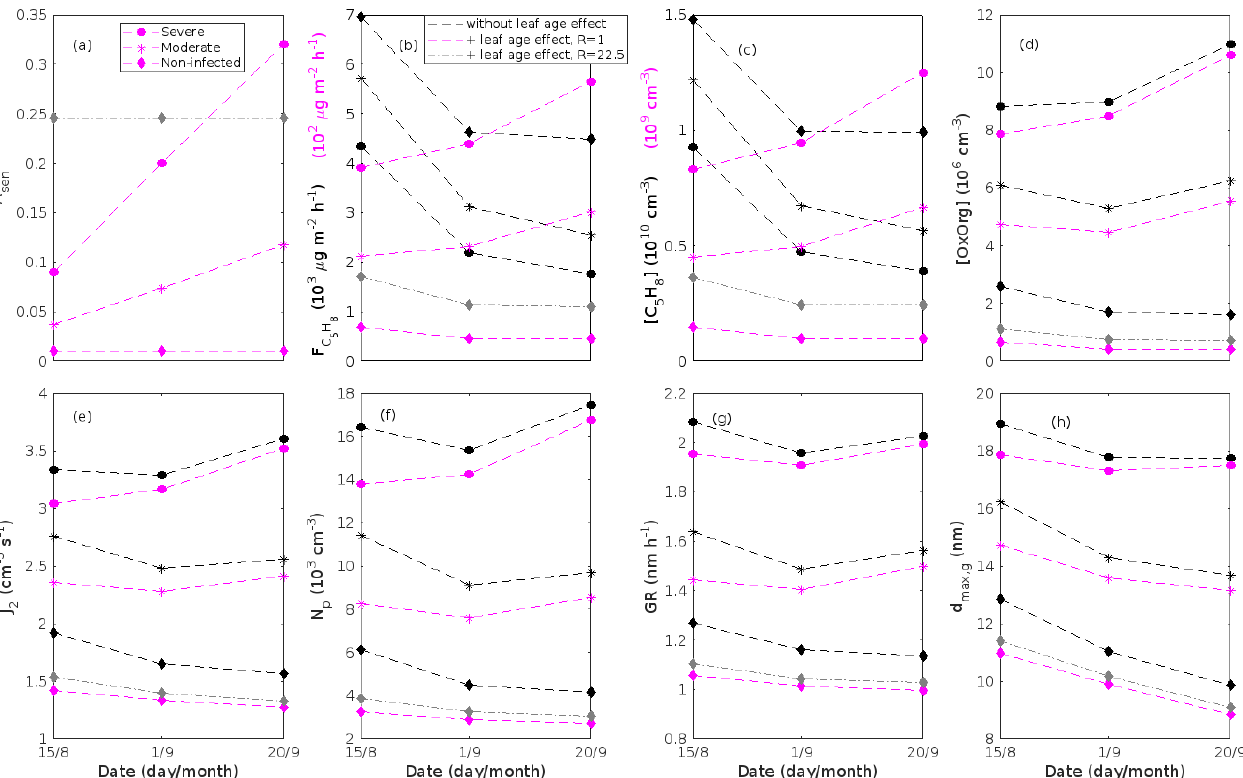
Figure B3. An oak stand infected by oak powdery mildew in comparison to a non-infected oak stand simulated with and without considering the impact of leaf age on the rates of isoprene emissions. (a) The fraction of isoprene emitted in comparison to simulations where the leaf age effect was not considered. For example, in order to reach R = 1 in simulations of a non-infected stand (magenta diamonds), the leaves are assumed to only emit 1% of isoprene compared to our default simulations of a non-infected stand (black diamonds in Fig. 7a). The syntax is equivalent to that of Guenther et al. (2012, p. 1476). (b) Canopy emissions of isoprene and atmospheric concentrations of (c) isoprene and (d) OxOrg. The units provided in black in (b) – (c) are connected to black and grey data points, while the units in magenta in (b) – (c) are connected to magenta data points. (e) Formation rate of 2nm particles, (f) number concentrations of formed particles, (g) growth rates of newly formed particles, and (h) the daily maxima diameter of the growing particle mode. The values of other parameters during these simulations are the same as in Fig. 7. “Moderately” and “severely” refer to 30% and 80% of the leaf area being infected by fungi by the 20th of September, respectively. Black markers are for simulations where the effect of leaf age was not considered (see Fig. 7 for R ), while magenta markers are for simulations where the emission of isoprene was reduced sufficiently for R to be just under 1. Grey diamonds are used to illustrate simulation results of a non-infected oak stand, where the emission of isoprene has been reduced sufficiently for R to be just under 22.5. Simulation results for severe are always indicated by circles, for moderate by asterisks, and for non-infected by diamonds (independent of whether the effect of leaf age was considered or